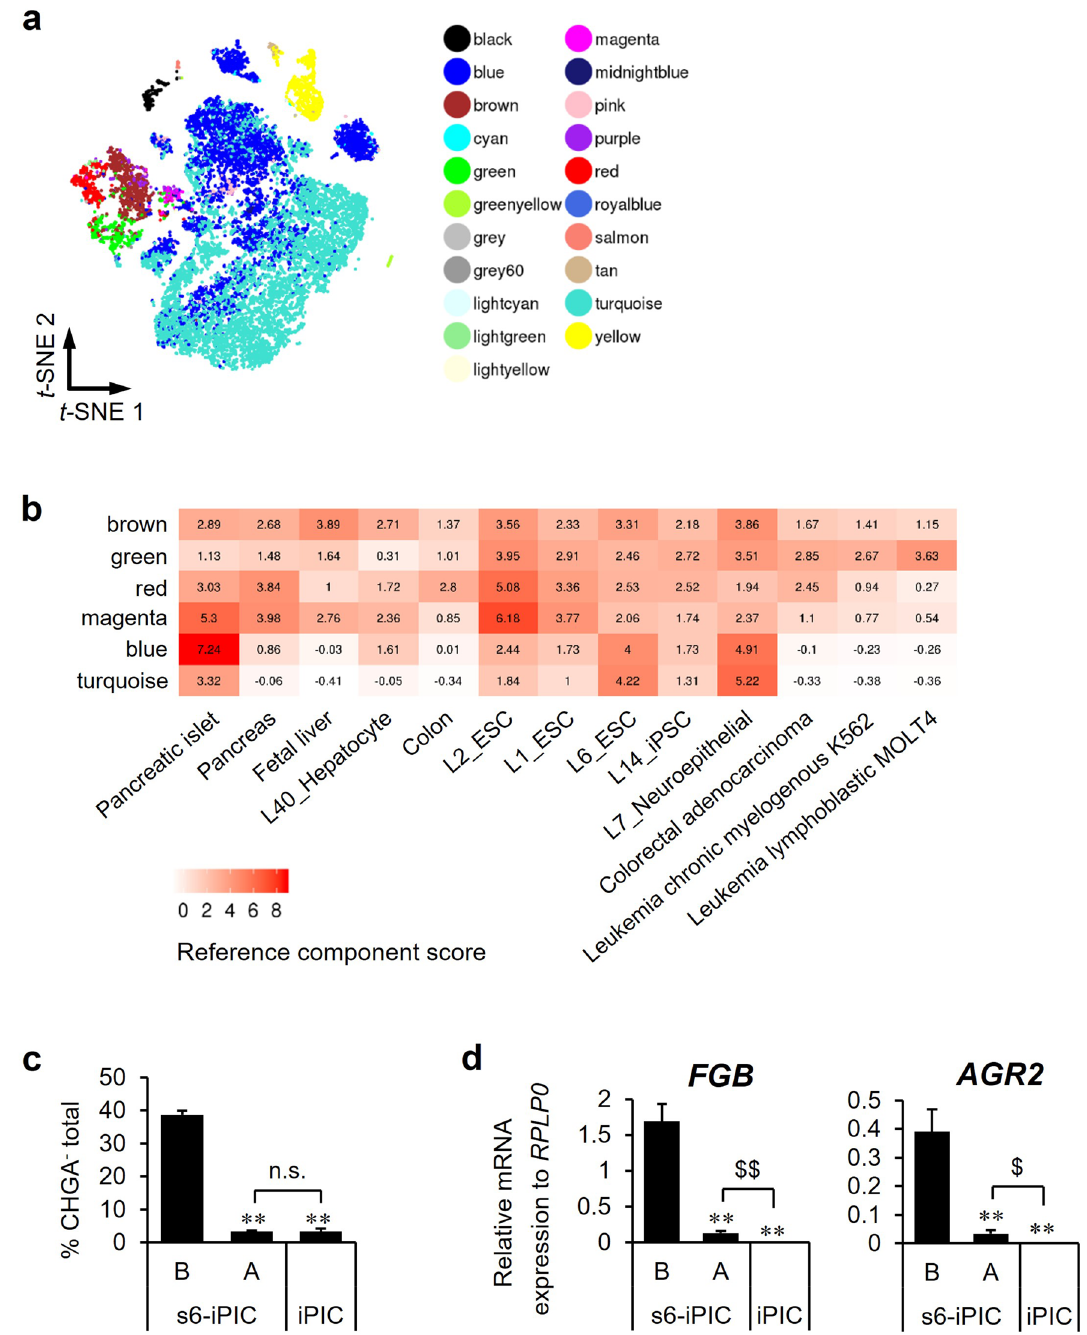
Figure 3. Detailed analysis focusing on non-endocrine cells and validation of identified markers for detecting non-endocrine subpopulations. ( a ) Newly classified cell populations by reference component analysis (RCA) on the t- SNE projection. ( b ) A heatmap of tissues and cell lines with high similarity (reference component score > 2.5) to non-endocrine cells (brown, green, red and magenta). See Supplementary Fig. 6b for the full RCA heatmap. ( c ) The proportion of putative non-endocrine cells (CHGA - ) for differentiated s6-iPIC-B, s6-iPIC-A and iPIC by flow cytometry analysis. Data are shown as the mean ± SD (n = 4, technical replicates). Reproducibility confirmed by 3 independent experiments. ** P < 0.01 versus s6-iPIC-B, Dunnett’s test. n.s.; not significant, Aspin-Welch t- test. ( d ) Validation of the identified novel non-endocrine markers in quantitative real-time PCR experiments. Expression levels were normalized to RPLP0 and are shown as the mean ± SD (n = 4, technical replicates). Reproducibility confirmed by 3 independent experiments. ** P < 0.01 versus s6-iPIC-B, Dunnett’s test. $$ P < 0.01, $ P < 0.05, Student